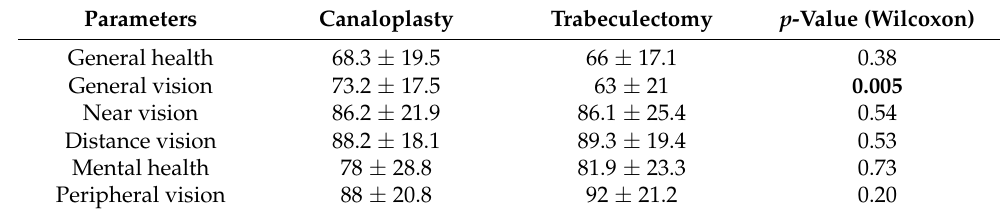
Values are reported as mean ± standard deviation. Statistically significant results are reported in bold text.